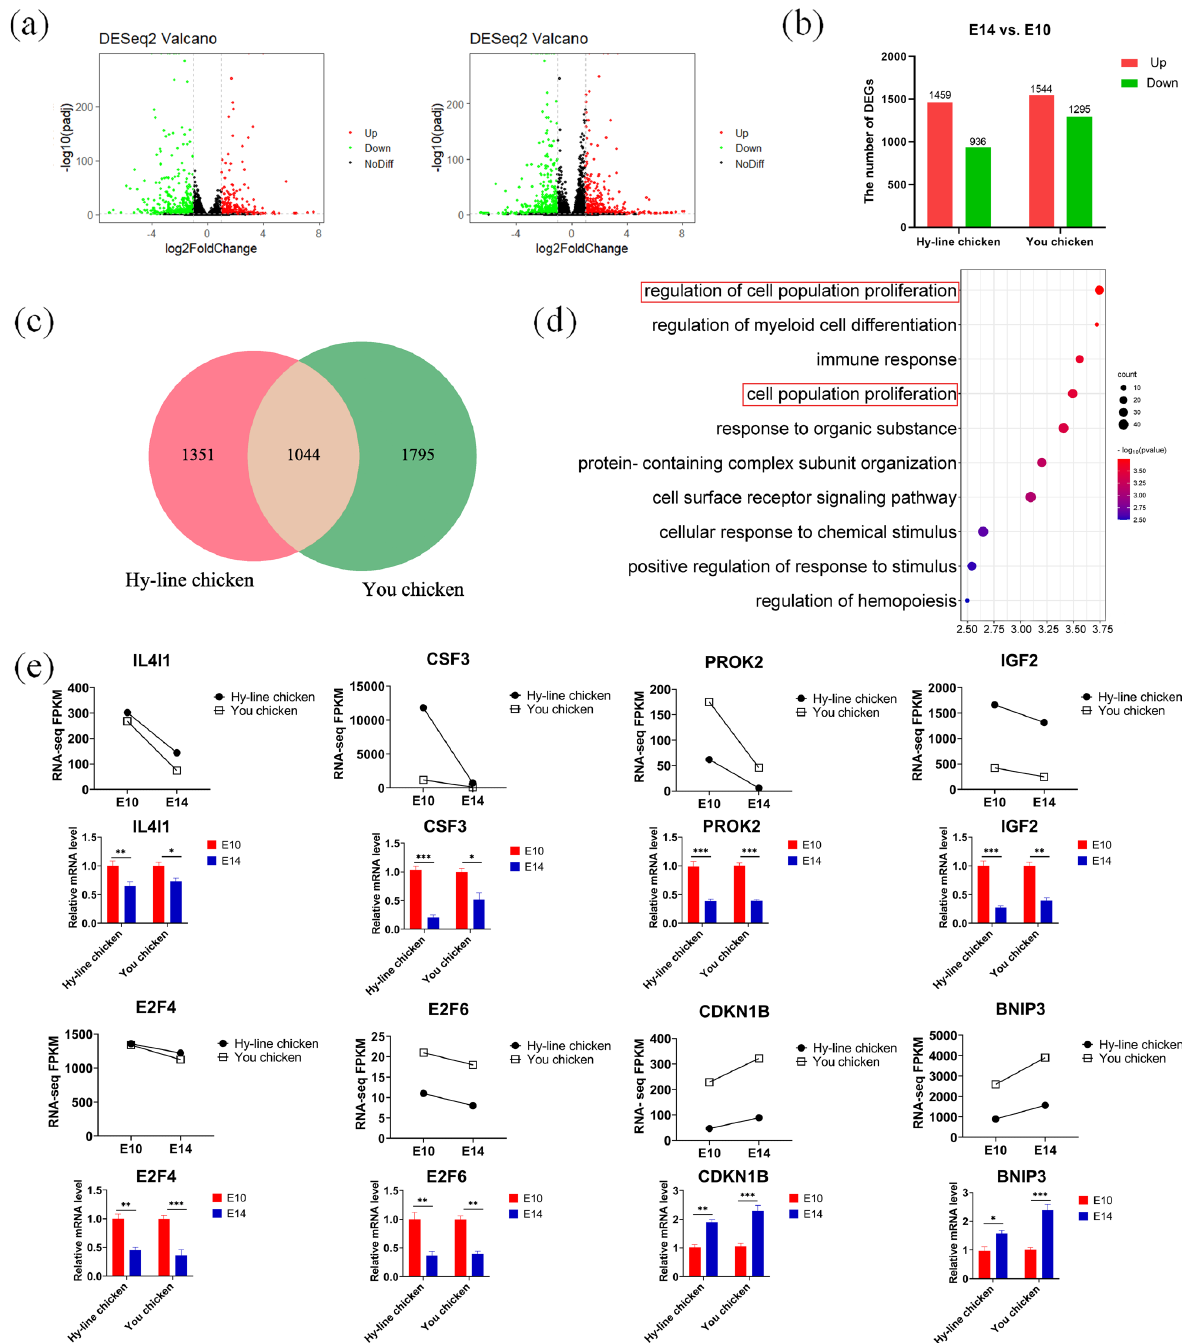
Figure 2. Differential co-expression genes involved in mitosis between Hy-Line chicken and You chicken. ( a , b ) Volcano map and histogram plots showing the differentially expressed genes between E10 PGCs and E14 PGCs, with the Hy-Line chicken group on the left and You chicken on the right. ( c ) The Venn diagram shows the differential genes co-expressed between the Hy-Line chicken and the You chicken groups. ( d ) Gene ontology terms enriched by 1044 DEGs. Colored shades represent p -values, and the size of the dot represents the number of genes. The redboxes indicate the enriched terms related to cell proliferation ( e ) Validation of key genes related to PGC proliferation by RT-qPCR. The line chart shows the change in FPKM values measured via RNA-Seq between E10 PGCs and E14 PGCs. The column chart shows the relative expression measured via RT-qPCR. Data were mean ± SEM, n = 5. * p < 0.05; ** p < 0.01; *** p <